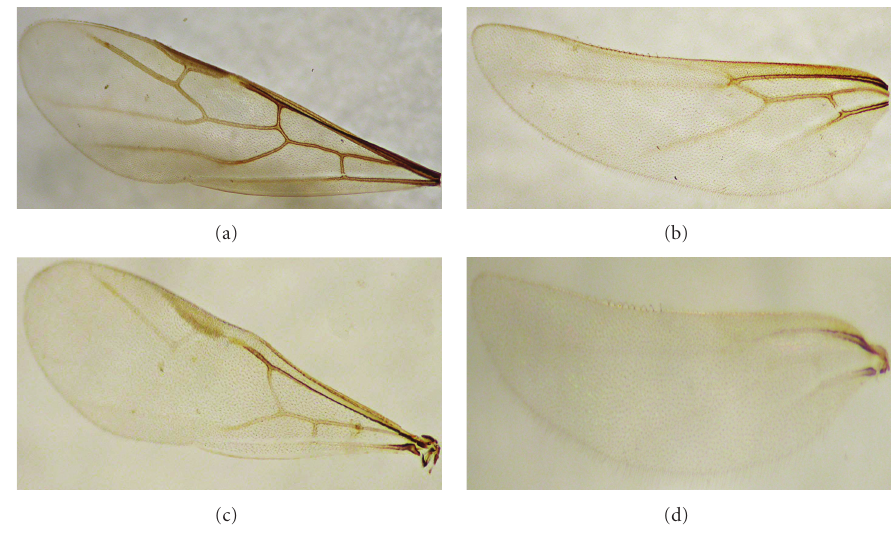
Figure 4: Wings of Dorymyrmex biconis. (a) Queen forewing; (b) queen hindwing; (c) male forewing; (d) male